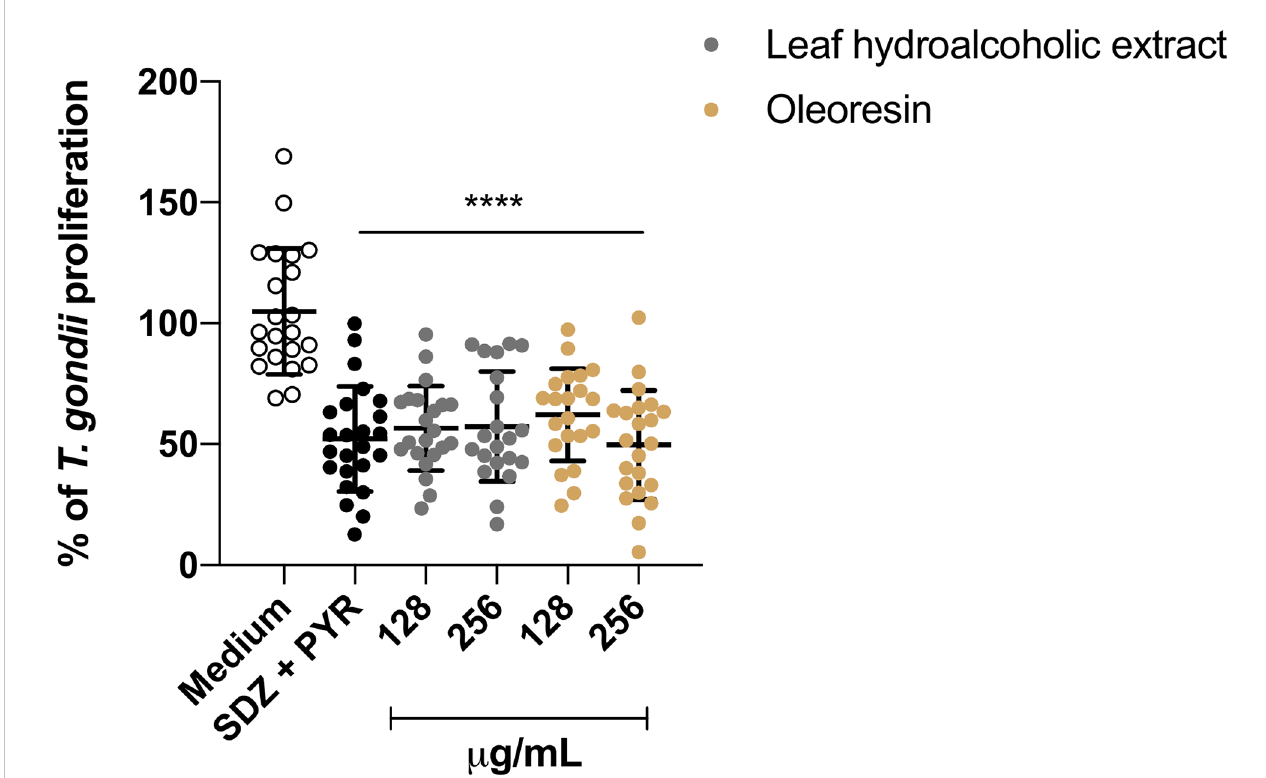
FIGURE 10 T. gondii intracellular proliferation. The human villous explants were infected with T. gondii followed by treatment for an additional 24 h with hydroalcoholic extract, oleoresin, SDZ+PYR or culture medium alone (medium). T. gondii intracellular proliferation was measured by b -galactosidase assay, and the number of tachyzoites was expressed as a percentage (% of T. gondii proliferation), and the untreated/infected (medium) was considered as 100% parasite proliferation. Data are expressed as means ± standard deviation of four experiments performed in six replicates. *Comparison with infected/untreated cells (**** P < 0.00001). Signi fi cant differences detected by One-way ANOVA, Bonferroni ’ s multiple comparisons post-test differences were considered when P <